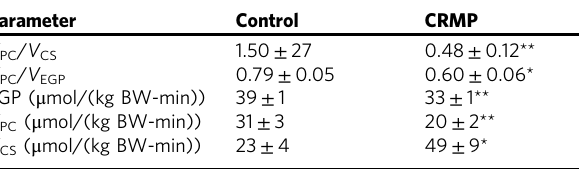
Table 1 PINTA detects increased V CS fl ux in high-fat-fed rats treated with a liver-targeted mitochondrial uncoupler Parameter